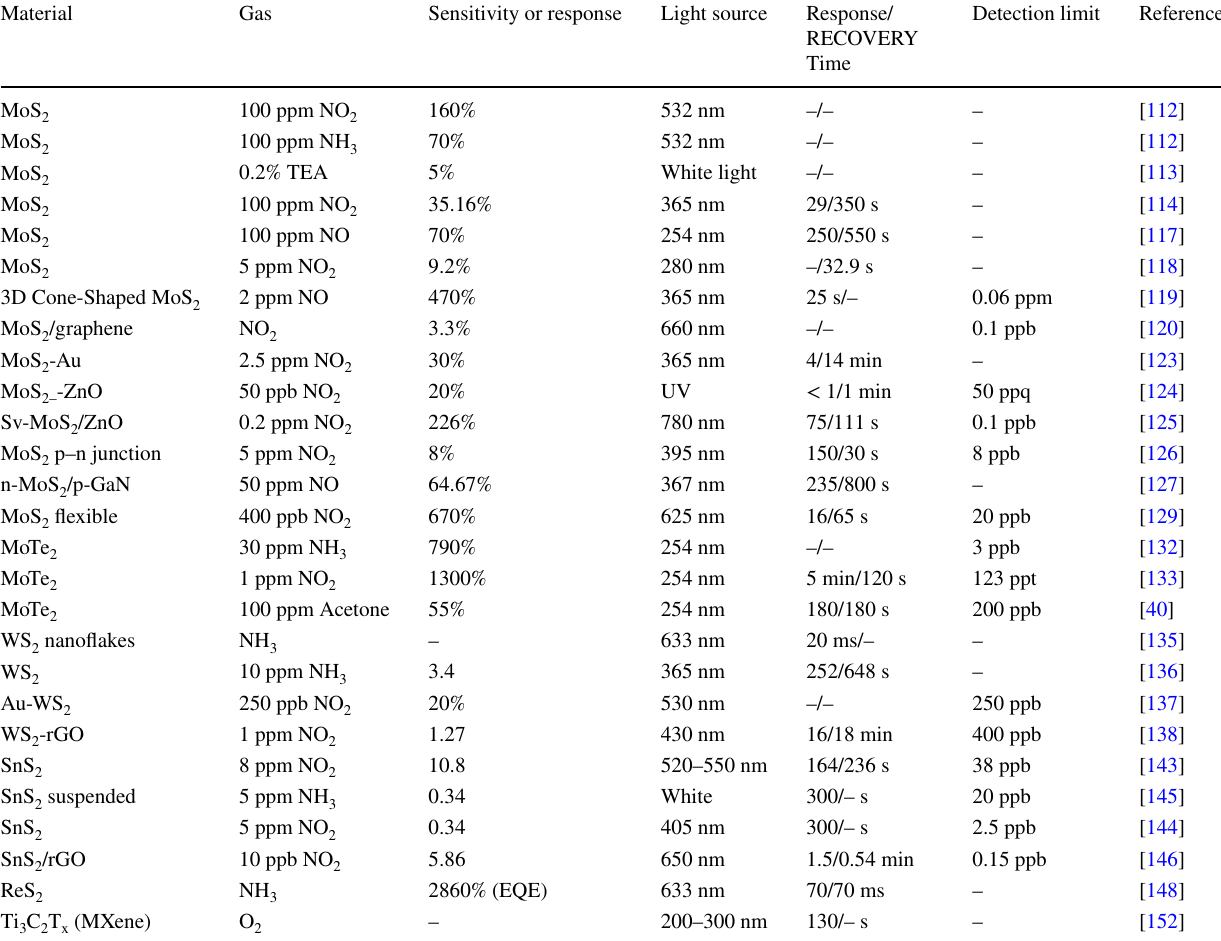
Table 3 Summary of 2D transition metal dichalcogenides and MXene gas sensors to various gases under photoactivation at room temperature